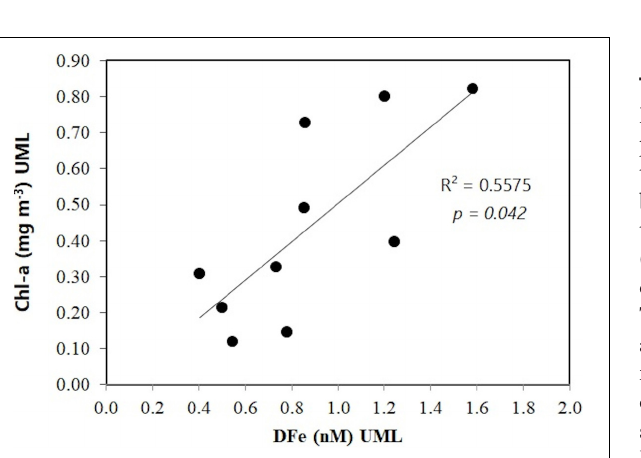
SSR region. The even higher concentrations north of the SSR indicate an enrichment after the SSR, in agreement with our proposed mechanism, but more detailed full water column data are needed to verify this. More recently, and on the basis of sparse empirical data, a model approach by Jiang et al. (2019) proposed that in the southern Scotia Sea, in the region between the SSI and the SOP, ∼ 70% of off-shelf Fe transport occurs below the surface mixed layer and is then re- supplied to the surface by vertical mixing. The model simulations consider up to 500 m depth, therefore showing that vertical mixing, indeed could be the mechanism to supply Fe from these depths to the upper water column via the ASF shallow component in the